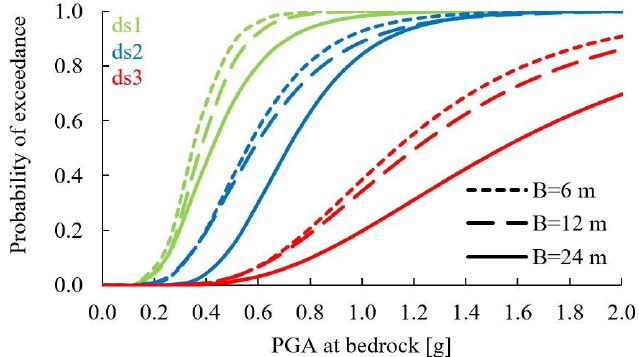
Figure 7. Influence of embankment width on fragility curves (damage state criteria for road embankments).